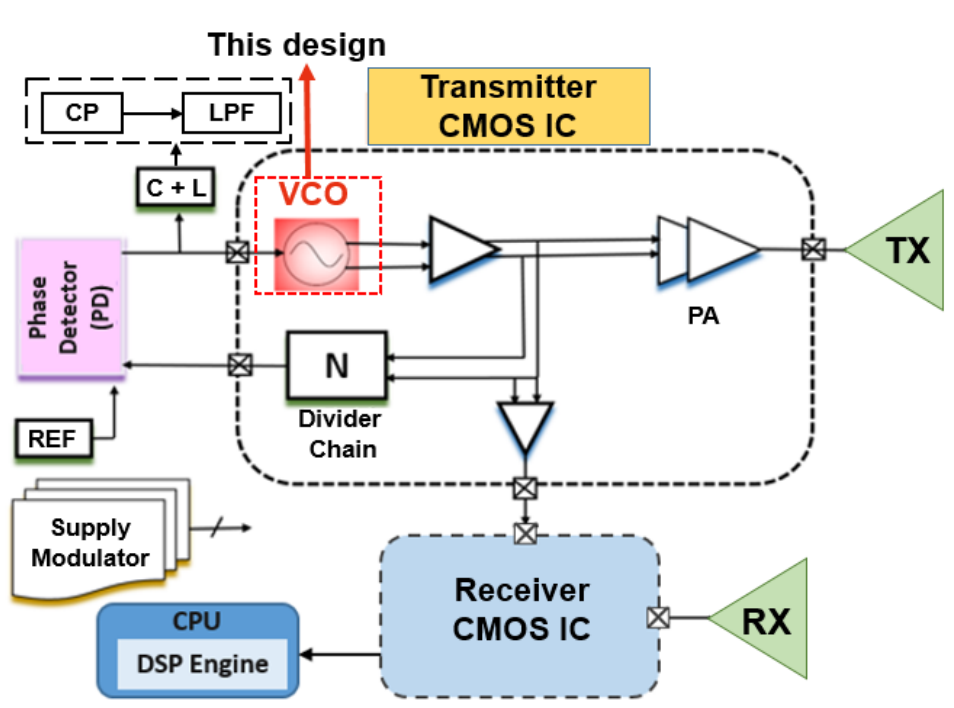
Figure 1. System-level architecture for 24 GHz radar communication.